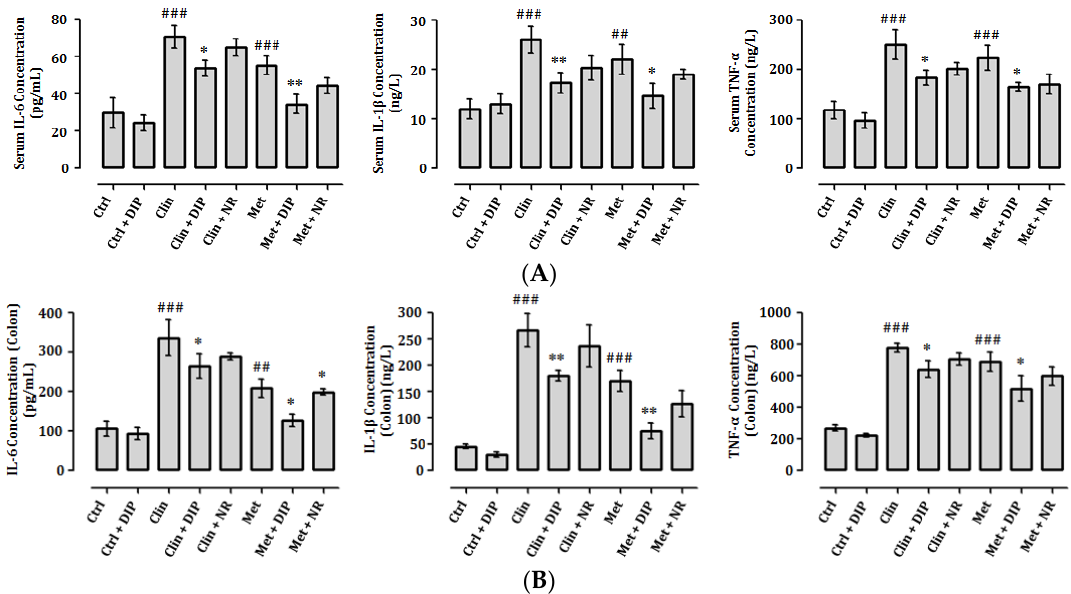
Figure 7. Pro ‐ inflammatory cytokine (IL ‐ 6, IL ‐ 1 β , and TNF ‐α ) measurement with ELISA in serum and colon. The levels of Pro ‐ inflammatory cytokines in ( A ) serum and ( B ) colon. The data are presented as the means ± standard error of mean SEM ( n = 6). Statistical significance was assessed by one ‐ way analysis of variance (ANOVA) followed by Tukey’s multiple comparison test and is represented as follows: ## p < 0.01 and ### p < 0.001 compared to the control; * p < 0.05, ** p < 0.01 compared to the respective antibiotic (Clin/Met) ‐ treated group). IL: interleukin; TNF: tumor necrosis factor.